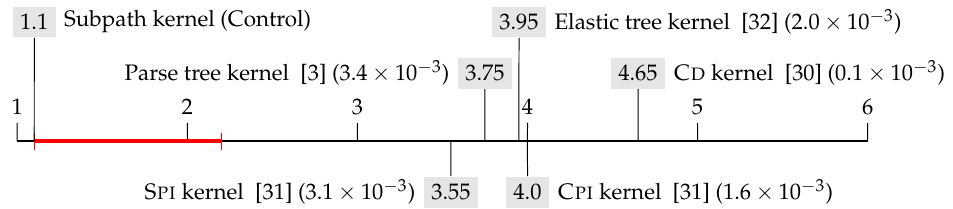
Figure 7. The averaged ranks and the p -values of Hommel test, displayed between parentheses, of the parse tree kernel [3], the elastic tree kernel [32], the S PI , C PI and C D kernels [30] with the subpath kernel as control. The red thick line represents the critical distance for the significance level 0.01.